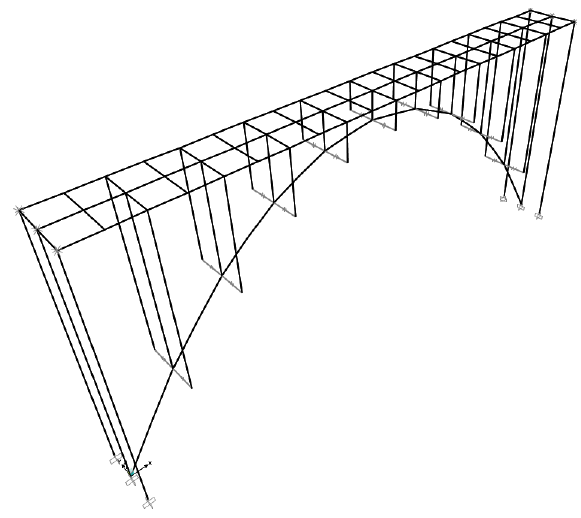
Figure 6. 3D FE model of the RC deck arch bridge assumed as case